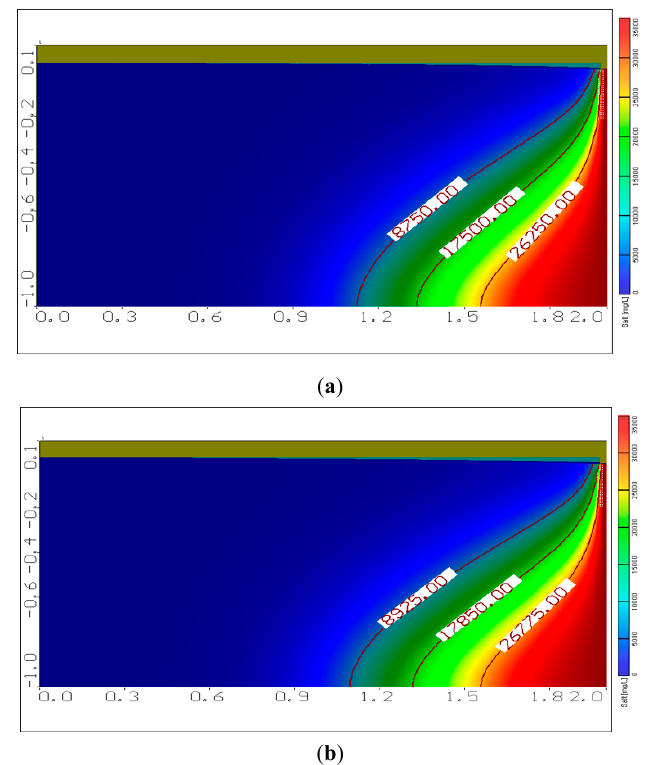
Figure 14. SWI due to decreasing freshwater influx by ( a ) 5% and ( b ) 10% .